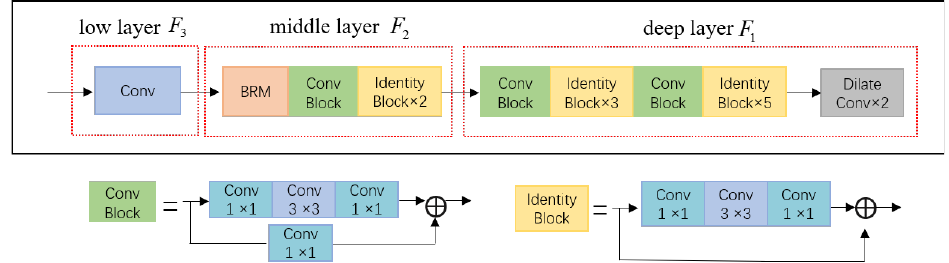
Figure 4. Feature extraction module. Through different convolution blocks, the features of different layers are obtained, which are low-level features 𝐹 3 , mid-level features 𝐹 2 , and deep features 𝐹 1 . layers are obtained, which are low-level features F 3 , mid-level features F 2 , and deep features F 1 An appropriate receptive field of deep features is key to the segmentation task. The